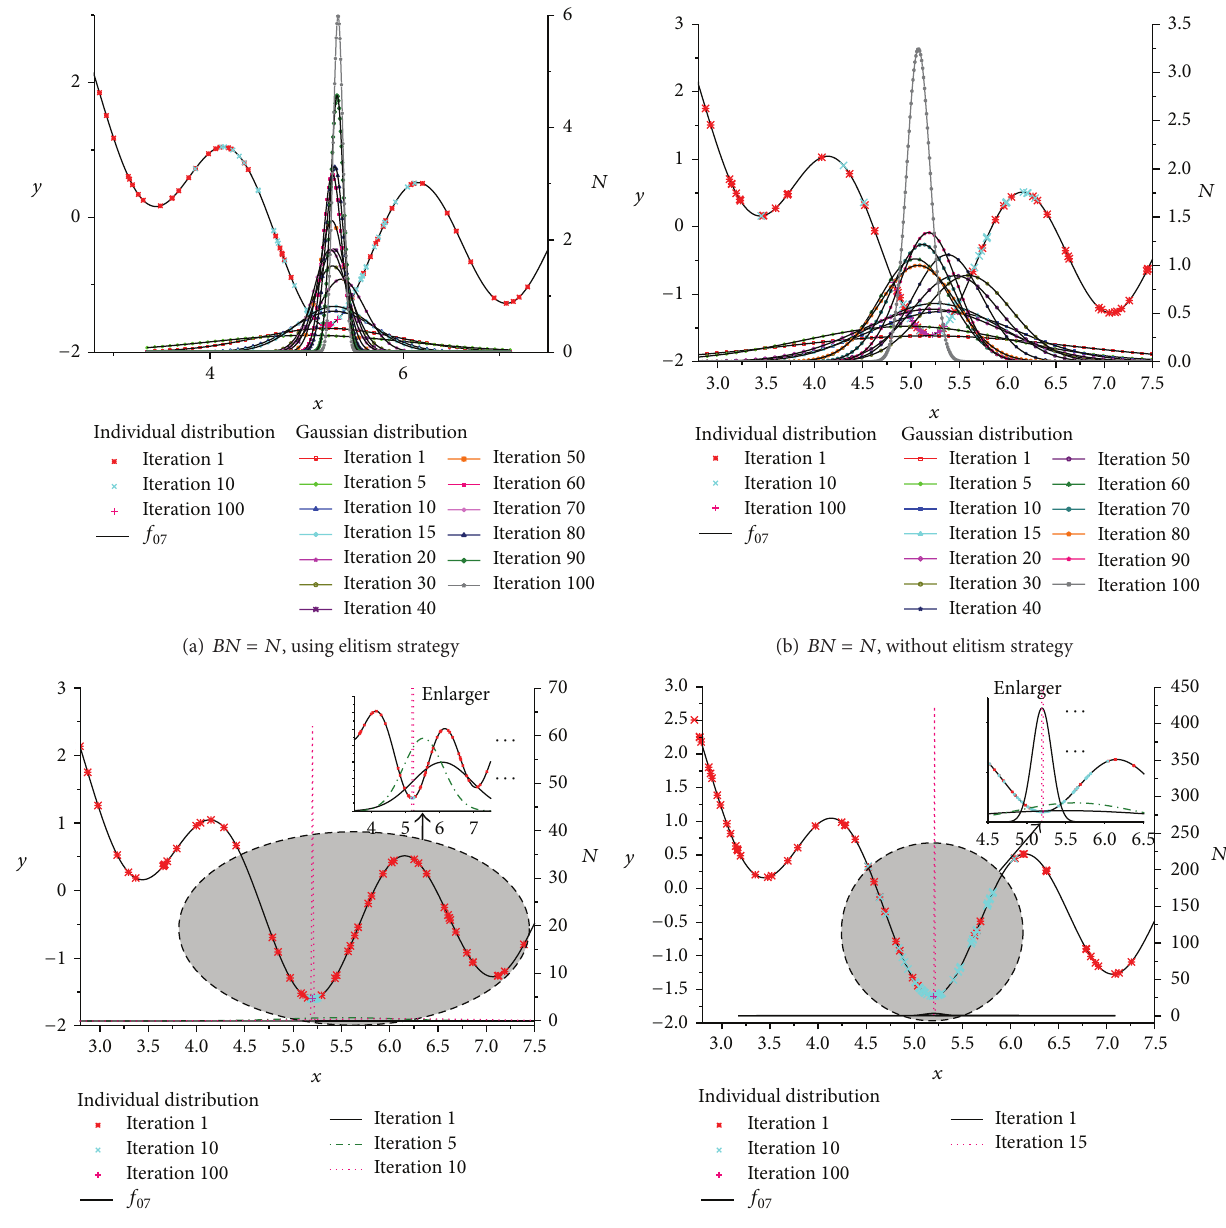
Figure 5: The individuals distribution and probability model of different iterations.